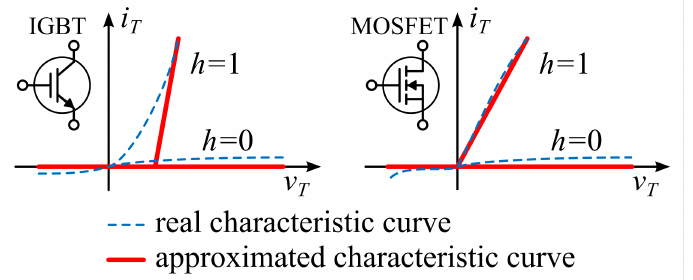
Figure 4. The v - i characteristics of the semiconductor devices, ON and OFF